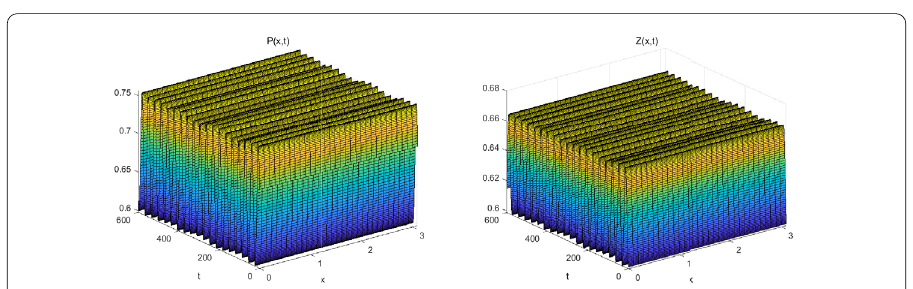
Figure 2 If m = 0.5, the stable periodic solutions bifurcate from the equilibrium E ∗ =